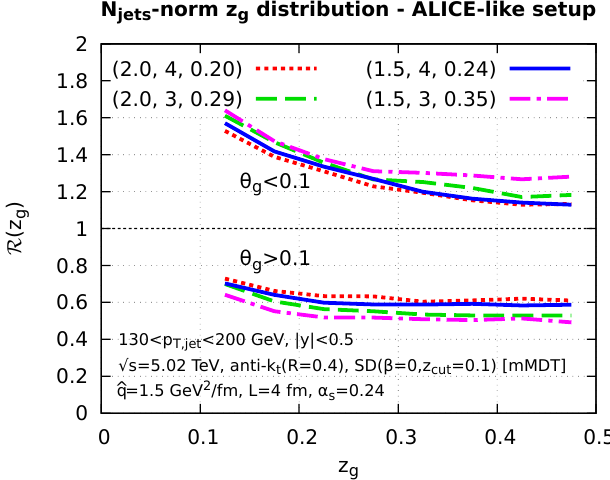
Figure 20 . Predictions of our Monte Carlo generator for the z g distribution obtained with a setup similar to the one used in the ALICE measurement of ref. [8]. We included the distribution obtained with either (cid:18) g < 0 : 1 (bottom set of curves), or (cid:18) g > 0 : 1 (top set of curves). In each case we